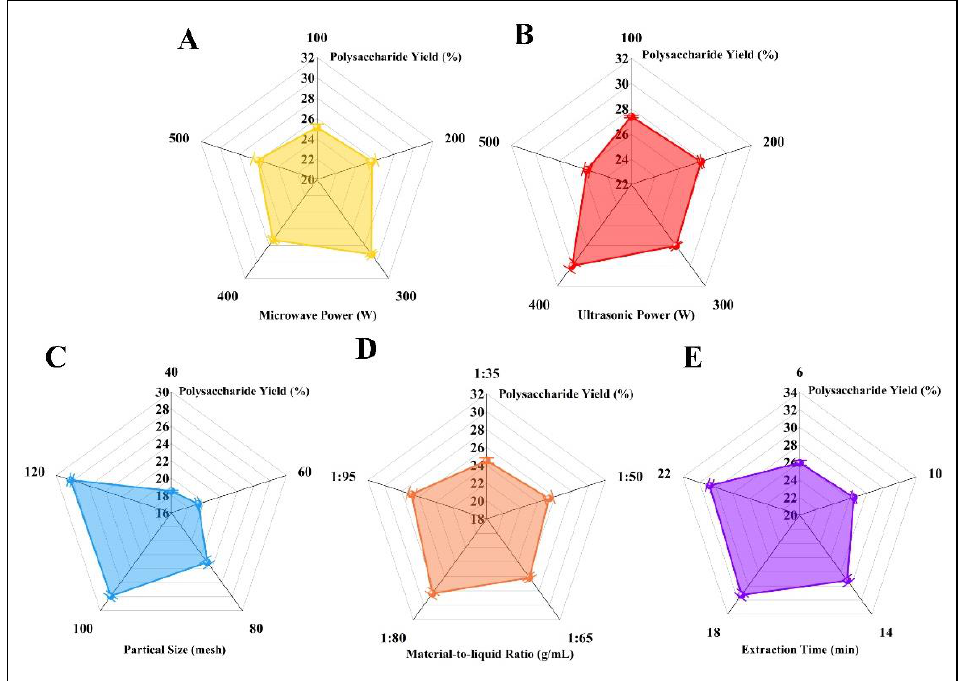
Figure 2. Effect of microwave power ( A ), ultrasonic power ( B ), particle diameter ( C ), liquid-to-material ratio ( D ), and extraction time ( E ) on the polysaccharide yield.